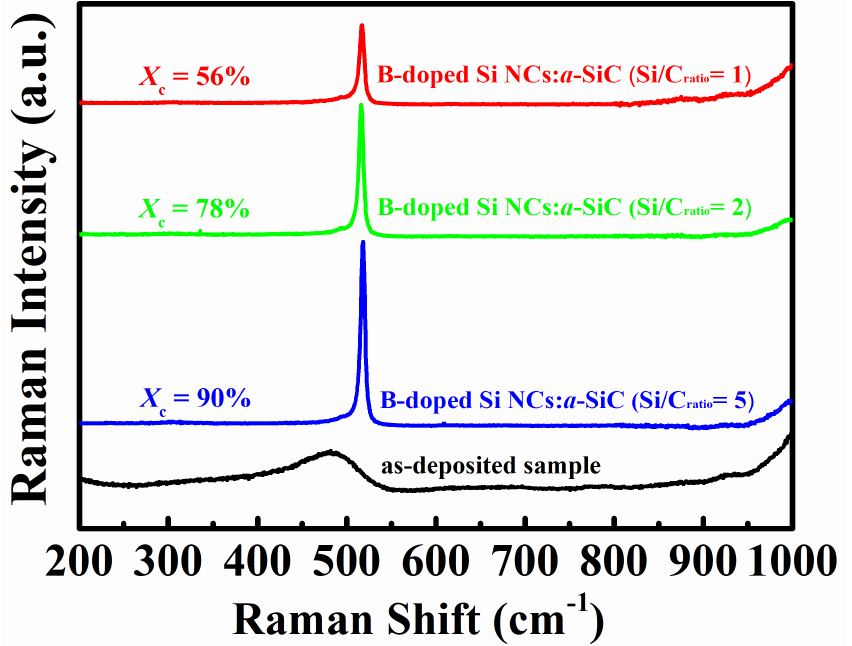
Figure 1. Raman spectra of B-doped Si NCs: a -SiC films with various Si/C